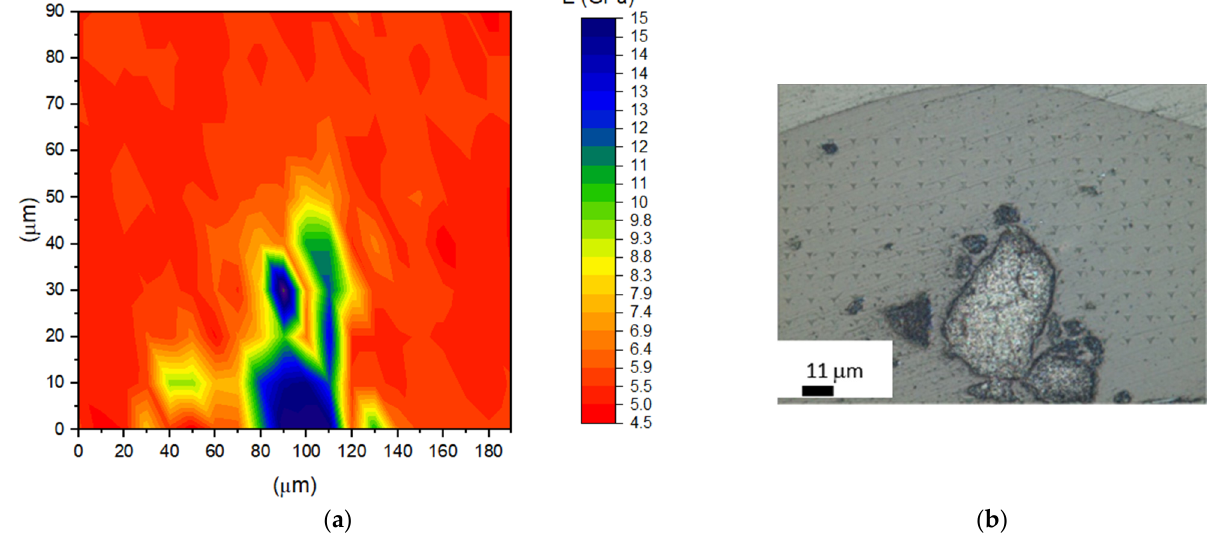
Figure 11. ( a ) Contour map showing the Young’s modulus distribution in EM field-treated PLLA9Mn; ( b ) OM picture of the area shown.